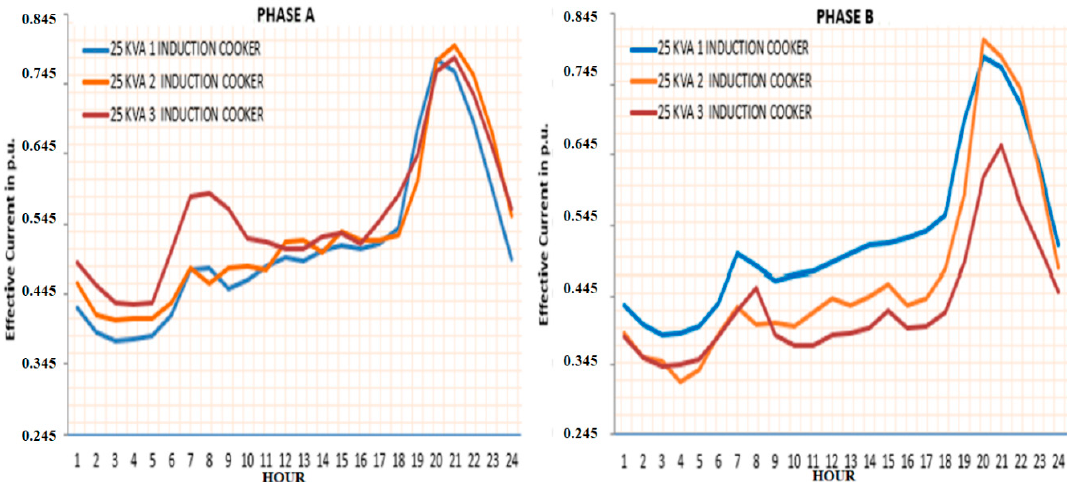
Figure 4. Typical graphs of effective harmonics currents in 25 kVA transformers with different numbers of induction cookers.